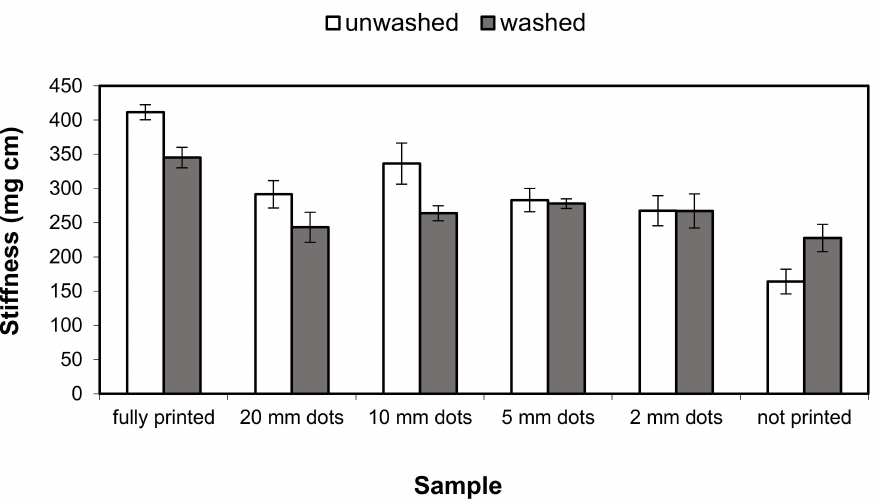
Figure 6. Stiffness of samples printed without pattern, samples printed by pattern (dots) and of not printed sample.